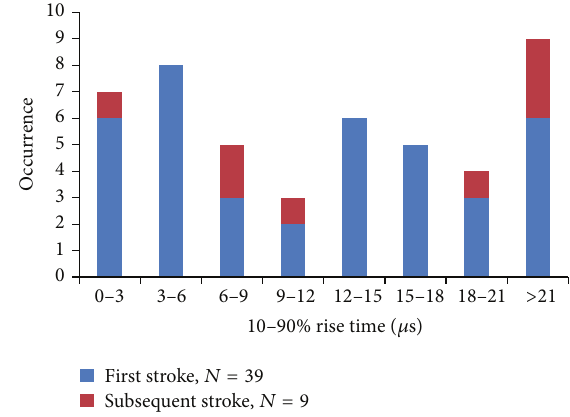
Figure 8: Histograms of 10–90% rise time for 48 positive return